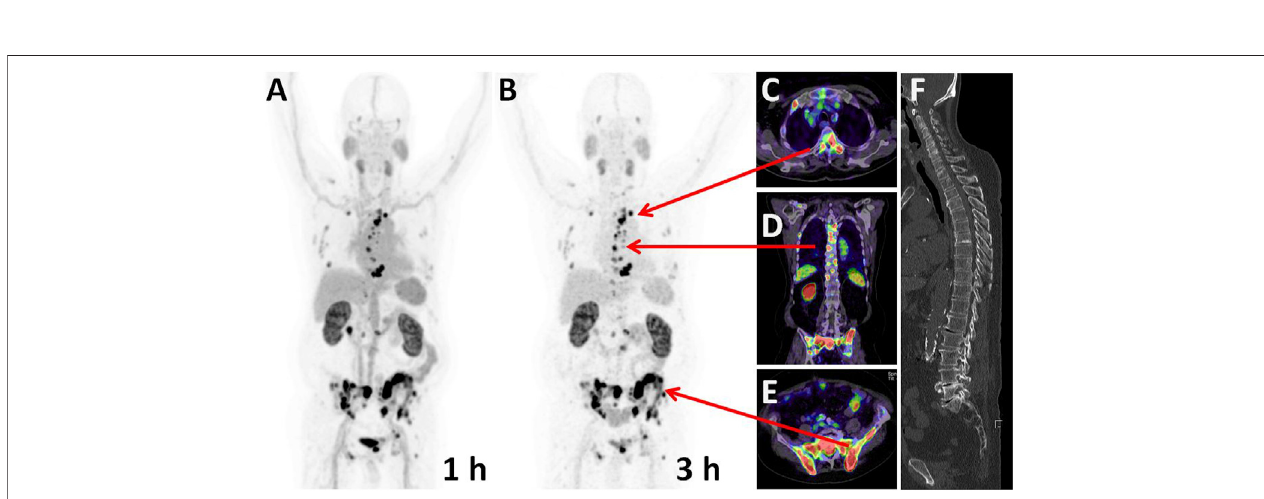
FIGURE 8 | Maximum intensity projections of a PSMA-PET of a prostate cancer patient performed 1 h (A) and 3 h (B) post injection of 295 MBq/20 nmol 68 Ga- CA030. Arrows point to the position of the cross-sectional slices demonstrating bone metastases in multiple regions of the axial skeleton (C – E) (F) In the CT, no typical osteoblastic reactions allowed tumor delineation by morphological information